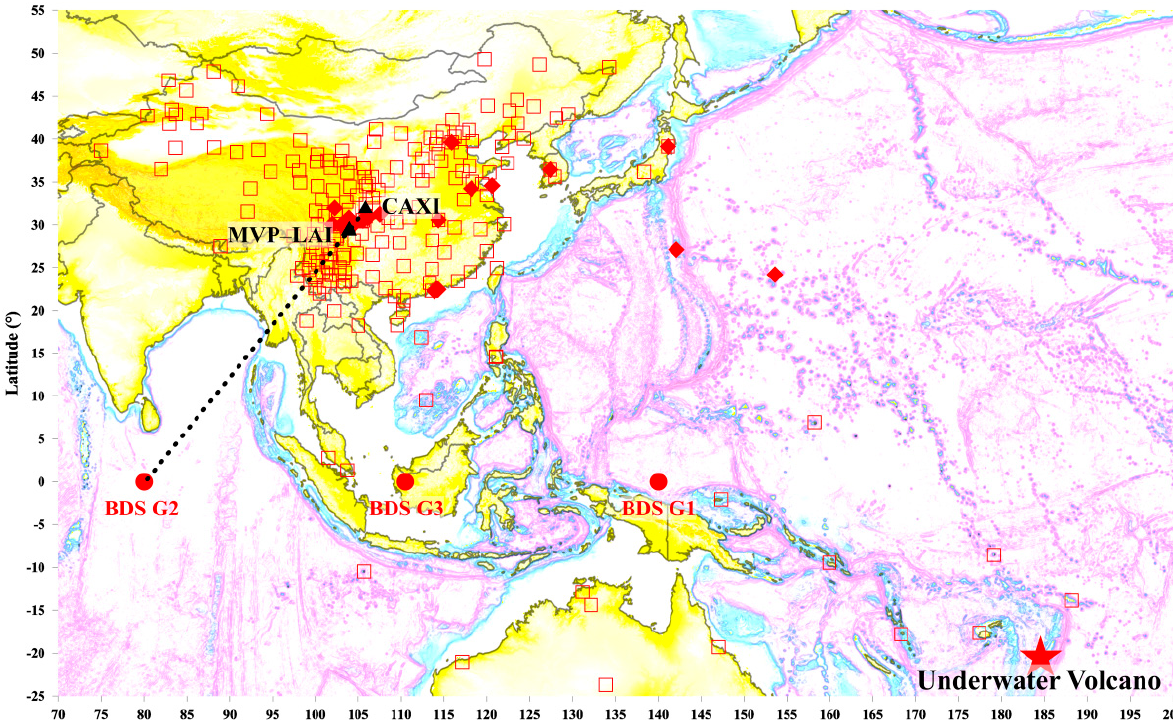
Figure 1. Locations of the ground-based GNSS receivers, barometers, and underwater volcano lying on the topography. The location of the Hunga Tonga-Hunga Ha’apai underwater volcano is shown by the red star. The red open squares denote the locations of the ground-based GNSS receivers utilized in this study. The red solid lozenges show the locations of the barometers. The red dots indicate the locations of the GEO satellites of the BDS. The black triangles indicate the MVP-LAI system and CAXI station. The black dashed line shows the line-of-sight of the signals transmitted from the BDS GEO satellite (G2) to the ground-based GNSS receiver at the CAXI station. The ionospheric pierce point (IPP) of the CAXI sTEC for BDS G2 locates above the MVP-LAI system at Leshan at an altitude of 350 km.